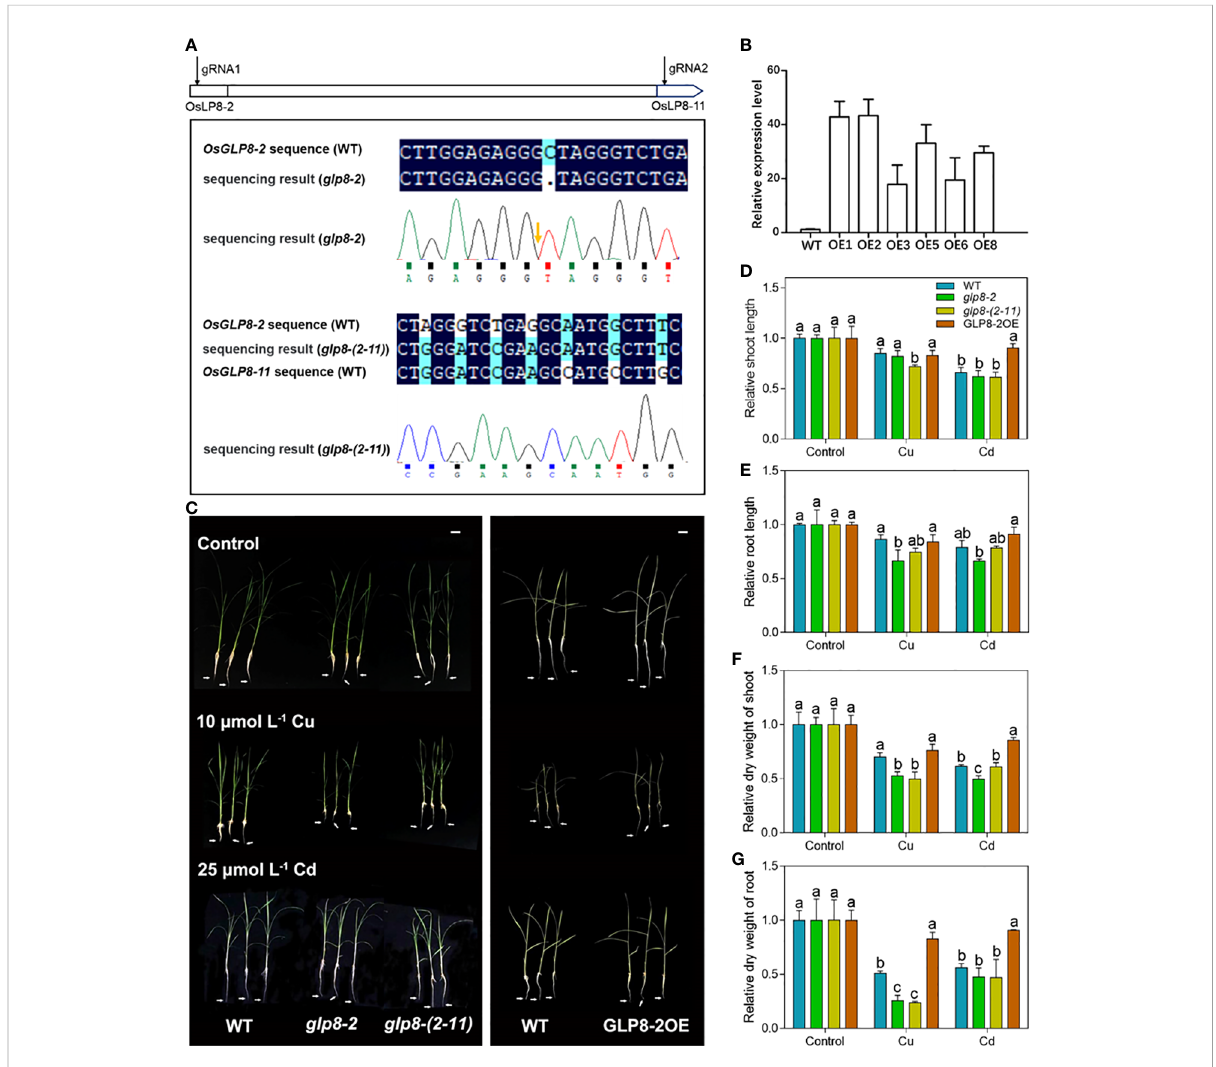
FIGURE 2 Knockout of O sGLPs results in the growth inhibition of rice seedlings. (A) Construction and identi fi cation of mutants. Two gRNAs were designed based on the exons of OsGLP8-2 and OsGLP8-11 near the ATG. Light blue and dark blue indicate successful sequence matching. Wavy lines are sequencing peaks. (B) Identi fi cation of OsGLP8 - 2 -overexpressing lines. (C) Phenotypes of two-week-old WT (wild type) and transgenic seedlings grown for 5 days under normal conditions, 10 m mol L − 1 CuSO 4 treatment, or 25 m mol L − 1 CdCl 2 treatment. Scale bar = 3 cm. (D, E) Root elongation of WT and transgenic plants. (F, G) Dry weight of WT and transgenic plants. Values are the mean ± SD; n = 3. Different letters indicate a difference of p ≤ 0.05 by the LSD